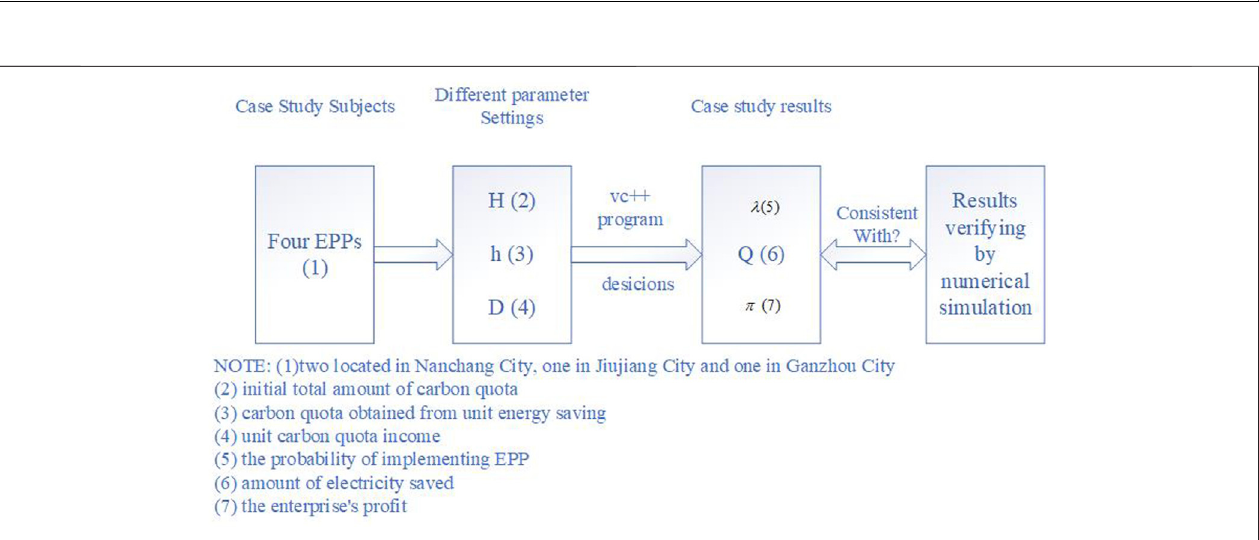
FIGURE 9 | (A) The relationship between enterprise E 3 earnings π 3 and λ (cid:6) − 1000 ≤ λ ≤ 1000 (cid:7) . (B) The relationship between enterprise E 3 earnings π 3 and λ (cid:6) 0 ≤ λ ≤ 1 (cid:7) .